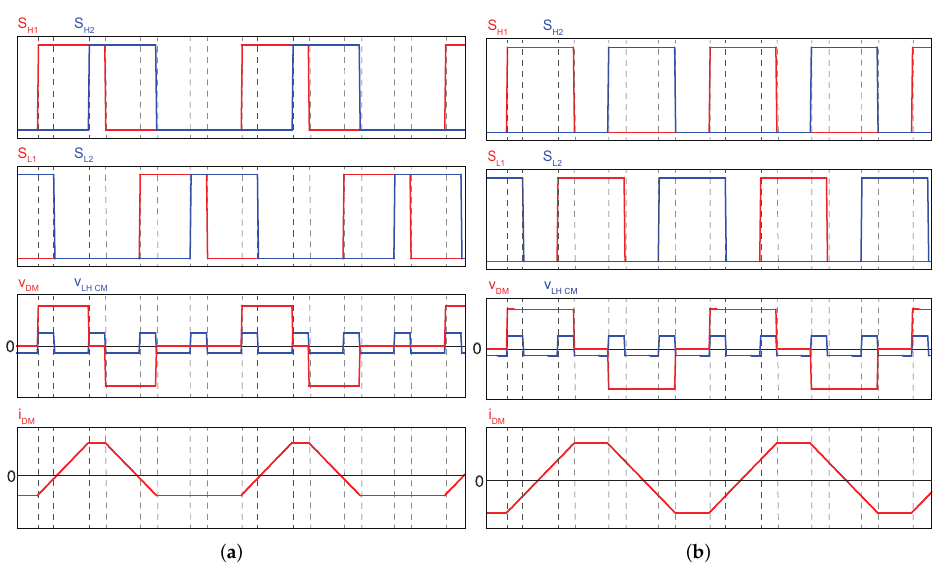
Figure 6. ( a ) Circulating current generated during Z-type interleaving; ( b ) circulating current generated during N-type interleaving.